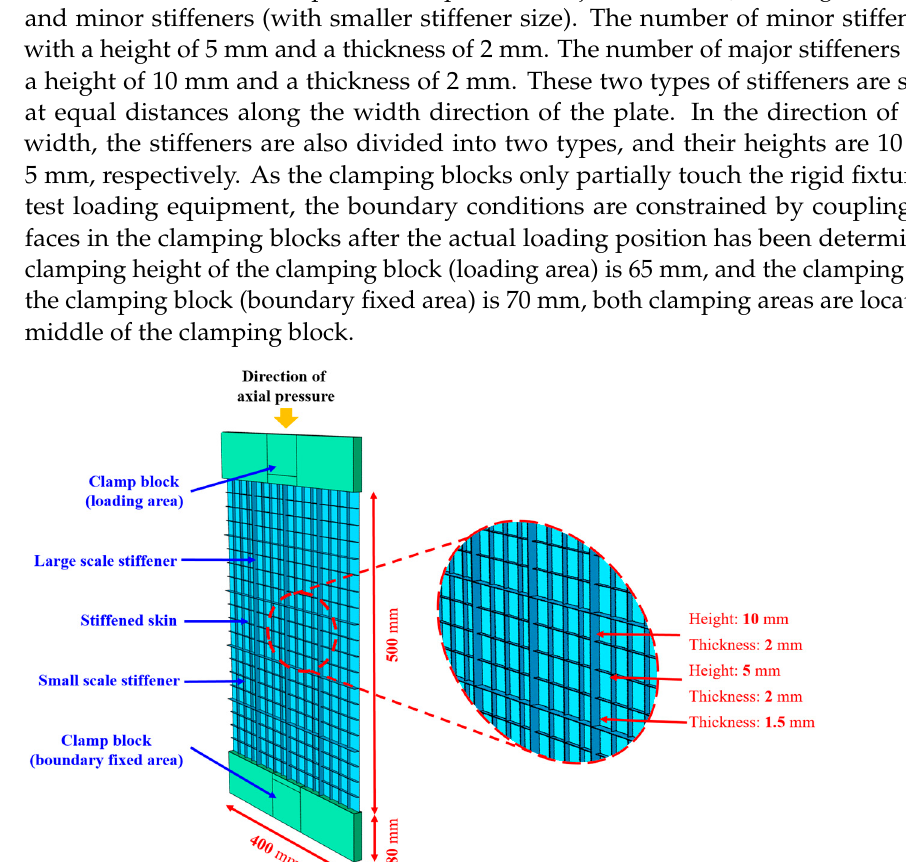
Table 1. Mises stress and computational cost with different numbers of elements of the hierarchical stiffened plate.